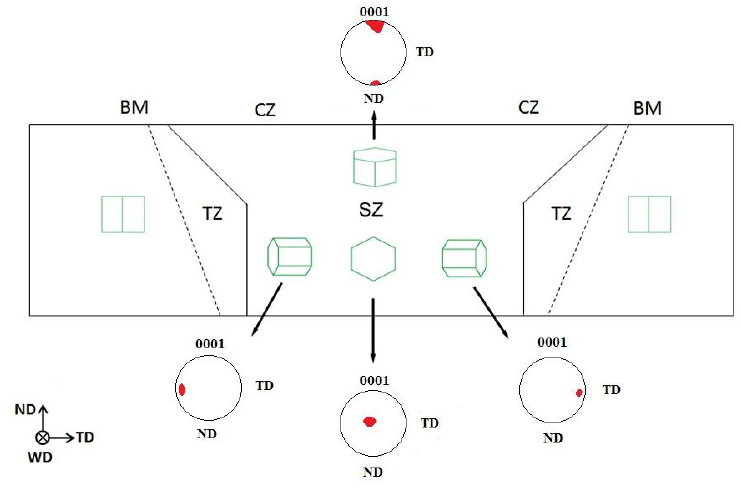
Figure 5. Texture distribution of the various regions of FSW joint (TZ: transition zone; SZ: stir zone; CZ: crown zone; TD: transverse direction; ND: normal direction; WD: welding direction).